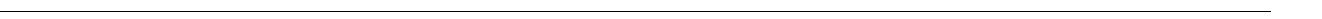
Fig. 1 Diabetes exaggerates discoid platelet thrombus growth under local fl ow disturbance in vivo. Control non-diabetic (non-DM) and diabetic (DM) mice were administered Dylight 649-anti-GPIb β Ab and Alexa 546-anti-P-selectin Ab, prior to subjection to the ‘ needle in situ ’ model of thrombosis, as described under ‘ Methods section ’ . In some experiments ( d ), mice were treated with vehicle or integrilin (as described) prior to needle injury. a Schematic illustration of the ‘ needle in situ ’ thrombosis model, wherein a microinjector needle is inserted into the center of the vessel lumen to create local fl ow disturbance. Thrombus formation is initiated at the needle tip and propagated by aggregating discoid platelets. Red blood cells (RBCs) have a collisional effect on platelets within the growing thrombus. b Thrombus growth (blue) and P-selectin expression (red) were monitored in real-time via confocal microscopy, with representative images depicting P-selectin − ve thrombi (blue) in both non-DM and DM mice, 4 min post-needle insertion. P-selectin + ve thrombi were detected only following injection of thrombin (green: collagen auto fl uorescence). c , d Thrombus surface area of non-DM and DM mice was quanti fi ed at the indicated time points post-needle insertion. c Results are expressed as mean ± s.e.m., n = 3 mice (6 – 8 thrombi per mouse examined in venules and 5 thrombi per mouse in arterioles). d Representative DIC images depicting thrombi (dotted line) forming 4 min post-needle insertion in non- DM and DM mice, either untreated (control) or treated with α IIb β 3 antagonist integrilin (4 mg kg − 1 , i.v.). e , f In some experiments, thrombi induced in non- DM and DM mice by needle perturbing mesenteric venules alone ( e ) was compared to local injection of thrombin (100 U mL − 1 ) ( f ). Thrombus formation was monitored using DIC intravital microscopy and thrombus surface area quanti fi ed at the indicated injury times. Results ( e , f ) are expressed as mean ± s. e.m. of n = 3 mice, (2 – 3 thrombi per mouse). For all studies, results were assessed using an unpaired, two-tailed Student ’ s t -test, where * p < 0.5; **** p